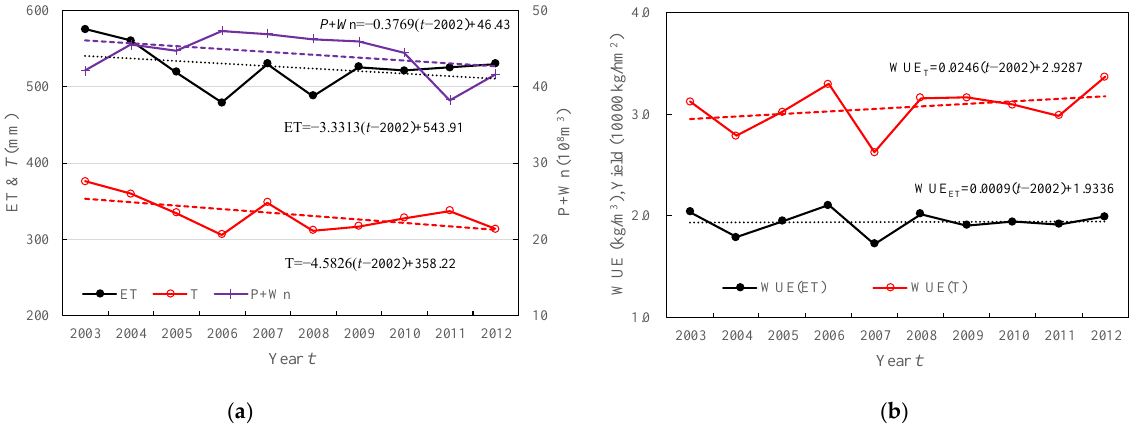
Figure 10. Variations in maize evapotranspiration (ET), transpiration (T), and total water input (precipitation + net water diversion, P+Wn) ( a ) and maize yield, WUE ET , and WUE T ( b ) in the study period.